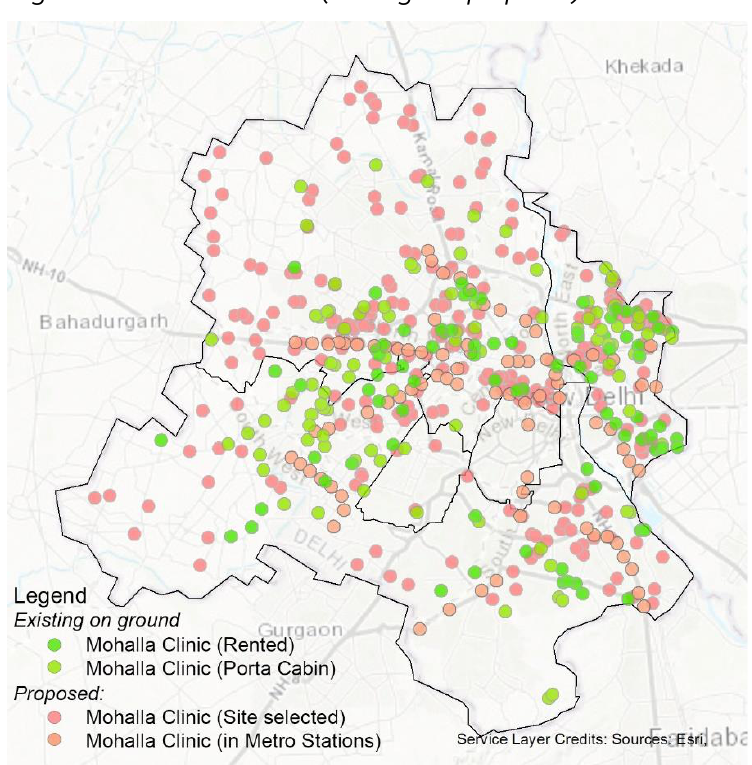
Figure 11: Mohalla Clinics (existing and proposed)